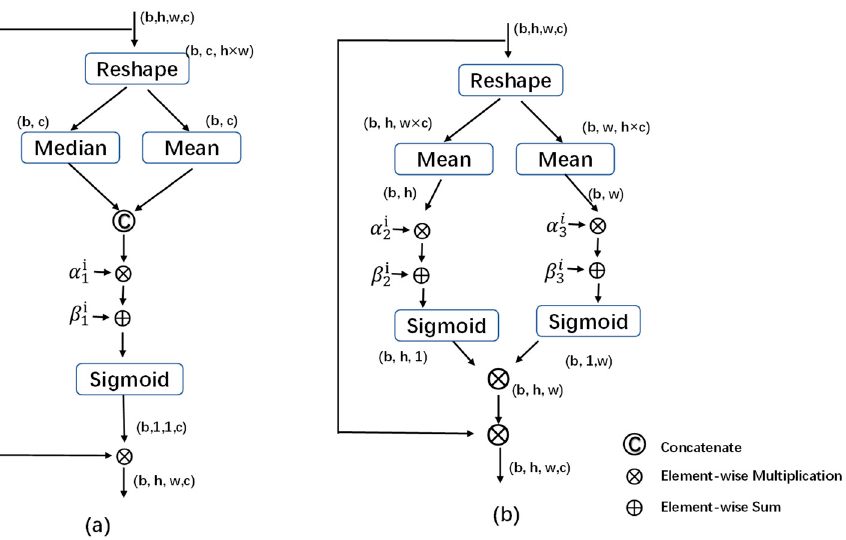
Figure 4. The detailed structure of PCSAM ( a ) for the channel attention module and ( b ) for the spatial attention module.